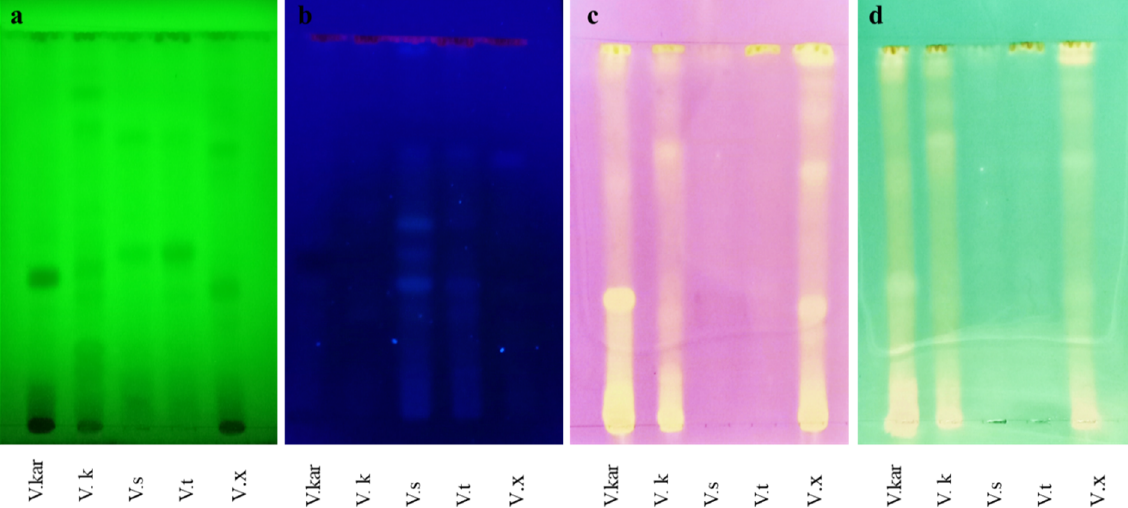
Figure 1. TLC chromatogram of five Vachellia extracts showing radical inhibitory compounds visualized using ( a ) UV- light, short wavelength (254 nm), ( b ) UV-light, long wavelength (365 nm), ( c ) DPPH and ( d ) ABTS + . Chromatogram was developed on a mobile phase: acetic acid:formic acid:water (8:1:1, v/v). Clear spots on a purple/blue-green background indicate inhibitory activity (Vx, V. xanthophloea ; Vkar, V. karroo ; Vk, V. kosiensis ) and less active (Vs, V. sieberiana ; Vt, V. tortilis ).